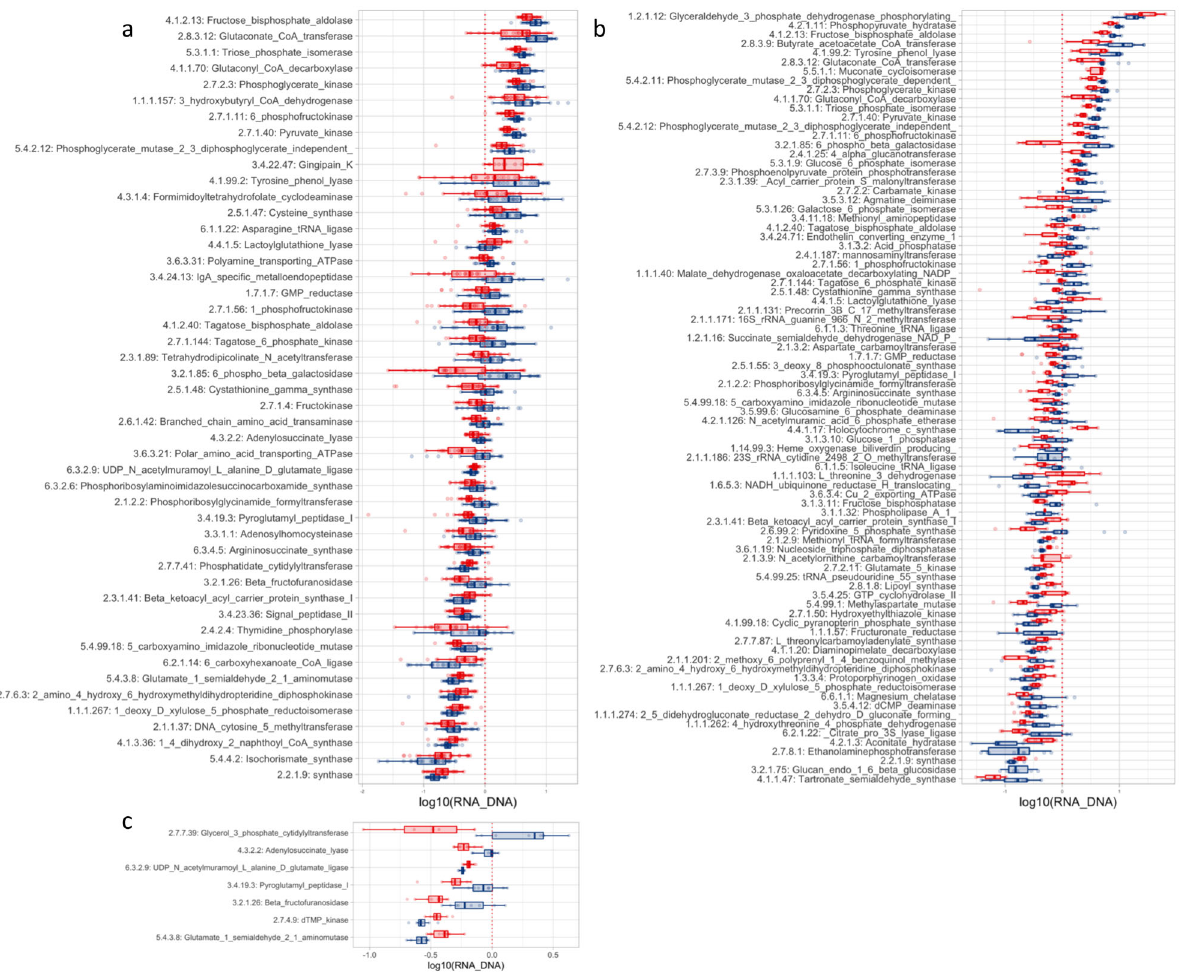
Fig. 5 Genes (matching EC numbers) differentially expressed (RNA/DNA ratio) between healthy patient and patient with periodontal disease. a Overall, b plaque, and c tongue bio fi lm. No gene was found differentially expressed within saliva oral site. Boxplots display fi rst quartile, median, and third quartile and whiskers represent 1.5 times the interquartile range from the fi rst and third